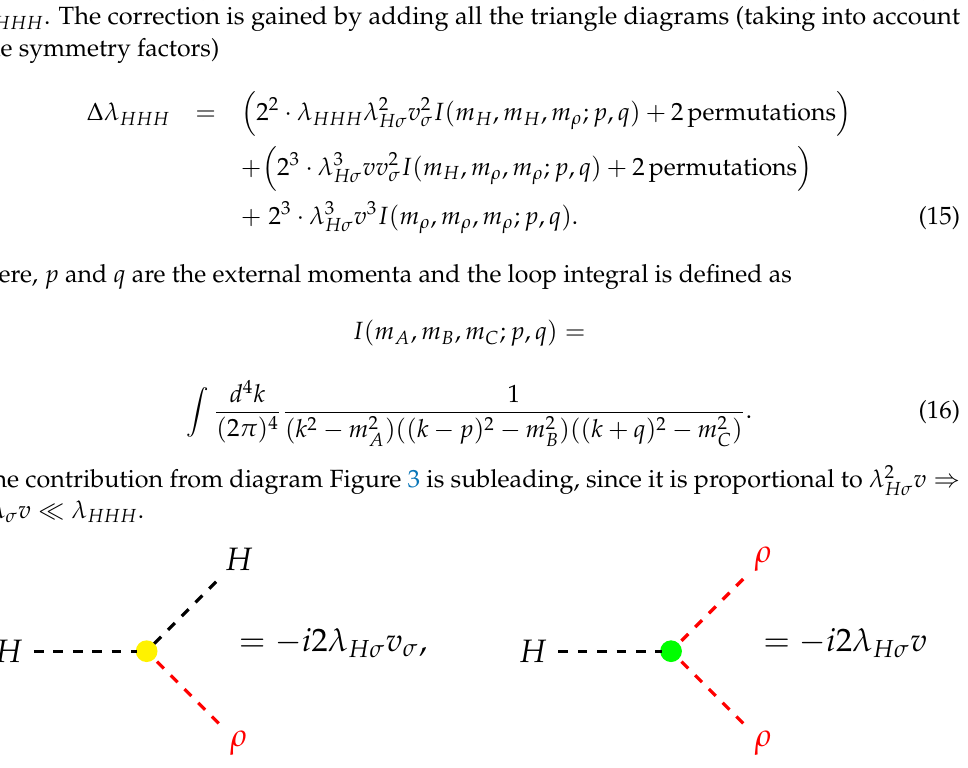
Figure 1. Vertex factors on trilinear vertices involving the SM Higgs boson as well as a real singlet ρ . They can be derived from Equation (2). We denote ρ and its propagator by red color.